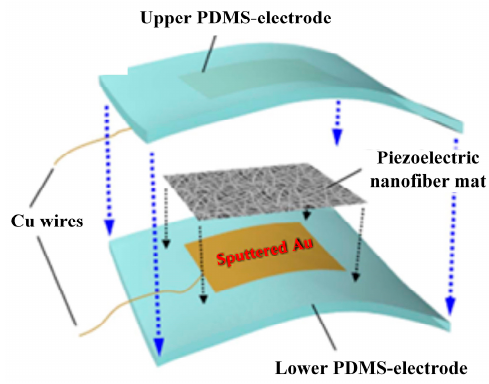
Figure 6. Schematic illustration of the configuration of the three-dimensional (3D) flexible piezoelectric sensor